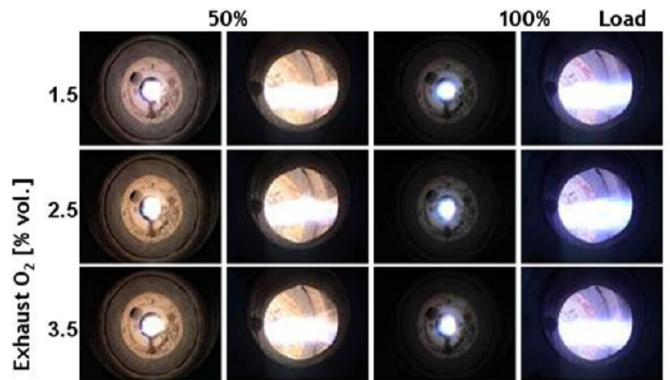
Figure 5. Flame images (front and side) for different combustion loads and exhaust O 2 concentra- tions for oxy-fuel combustion.